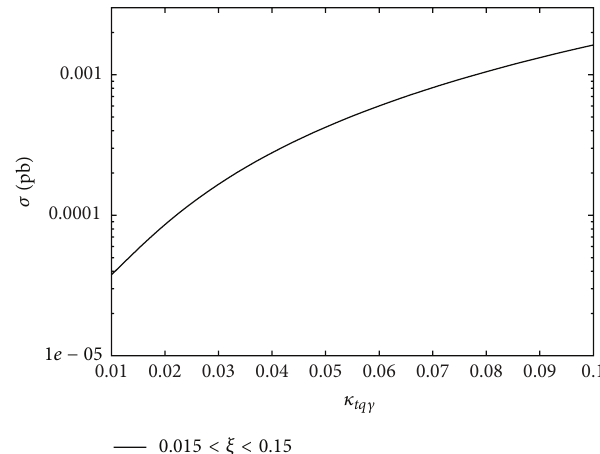
Figure 3: Total cross section of 𝑝𝑝 → 𝑝𝛾𝑝 → 𝑝𝑡𝛾𝑋 → 𝛾𝑋 as a function of anomalous coupling 𝜅 𝑝𝑏ℓ + ] ℓ detector acceptance is taken to be 0.015 < 𝜉 < 0.15 .